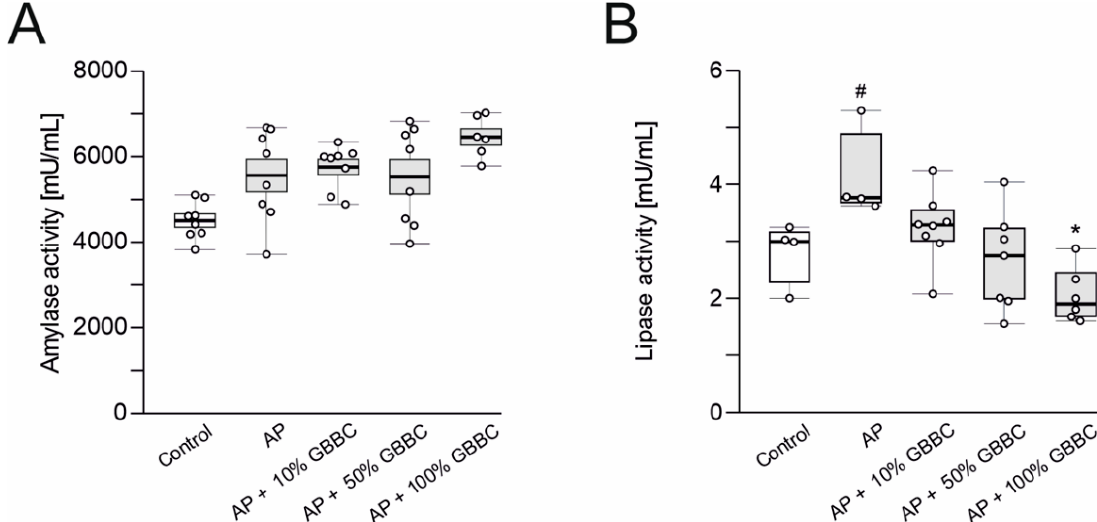
Figure 2. Amylase activity ( A ) and lipase activity ( B ) in the blood serum of healthy mice, mice with evoked acute pancreatitis (AP), and mice with AP after administration of increasing concentrations of ghee butter from bovine colostrum (GBBC). Data presented as raw data (circles) and means (horizontal bolded lines) with SEM (boxes) ( A ) or median with IQR (B). Significance estimated with the use of one-way ANOVA followed Dunnett’s post hoc test or with the use of the Kruskal–Wallis test with Dunn’s post hoc test for data departing from normal distribution. n = 4–8; # (hash) denotes comparison to control. * (asterisk) indicates comparison to AP (acute pancreatitis). #/* denotes p < 0.05; ##/** denotes p < 0.01; ###/*** denotes p < 0.001.